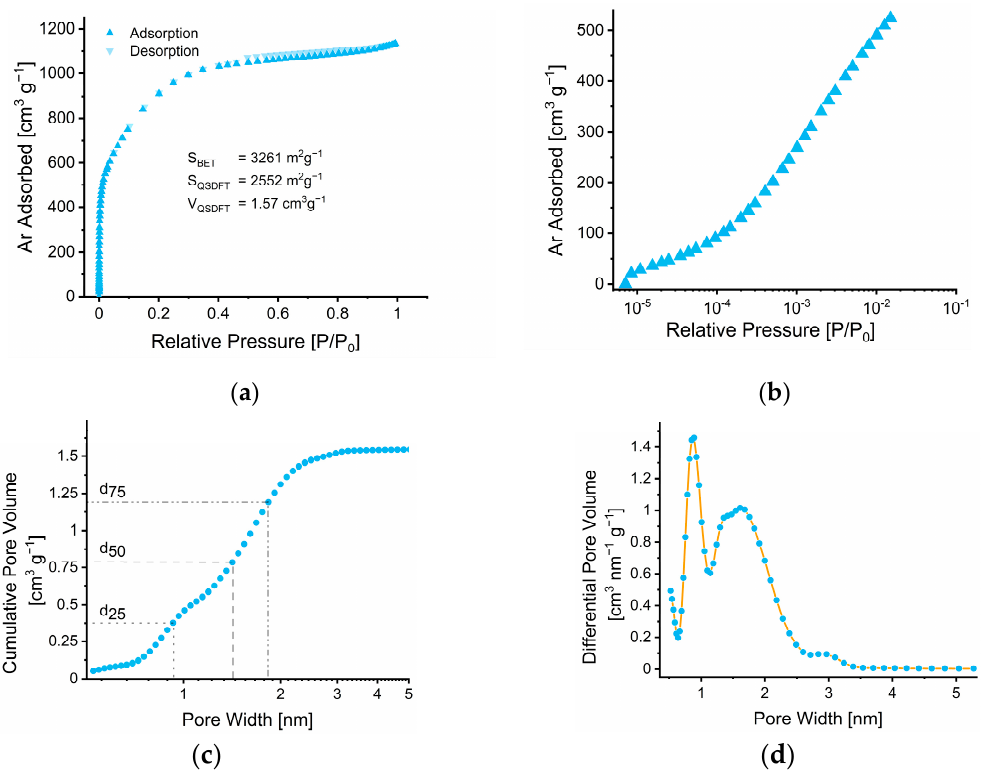
Figure 3. ( a ) Ar gas adsorption (triangle symbol facing up) and desorption (triangle symbol facing down) isotherms collected at 87.3 K for the degassed AC—CSS material and ( b ) the semi-logarithmic plot of the adsorption isotherm highlighting the micropore filling up to 10 − 1 P/P 0 . ( c ) Cumulative pore volume versus pore width and ( d ) differential pore volume versus pore width plots derived by the QSDFT carbon slit-pore model for Ar adsorption at 87.3 K.